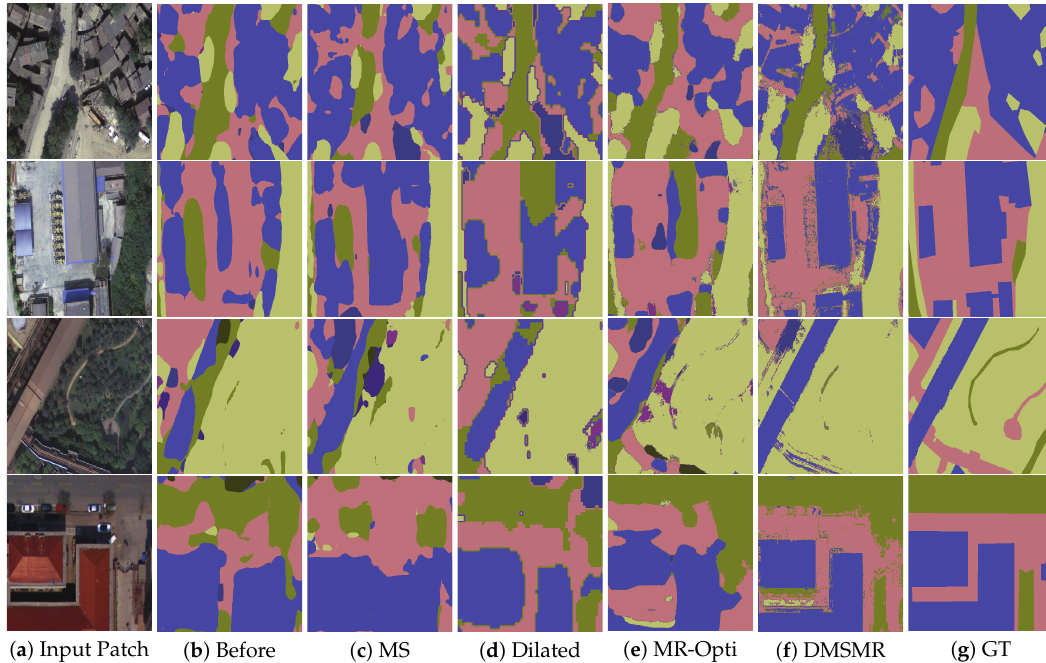
Figure 7. Semantic segmentation results with different strategies on the EvLab-SS validation patches. Four kinds of image patches with different spatial resolutions and illuminations are depicted in the figure. The first and second rows are the GeoEye and World-View 2 satellite images with resample GSD of 0.5 m and 0.2 m. The third and the last rows are the aerial images with resample GSD of 0.25 m and 0.1 m, respectively. MS : Predictions with multi-scale approach. MR-Opti : Semantic segmentation results using manifold ranking optimization method. DMSMR : Segmentation result predicted by dual multi-scale manifold ranking network. GT : Ground